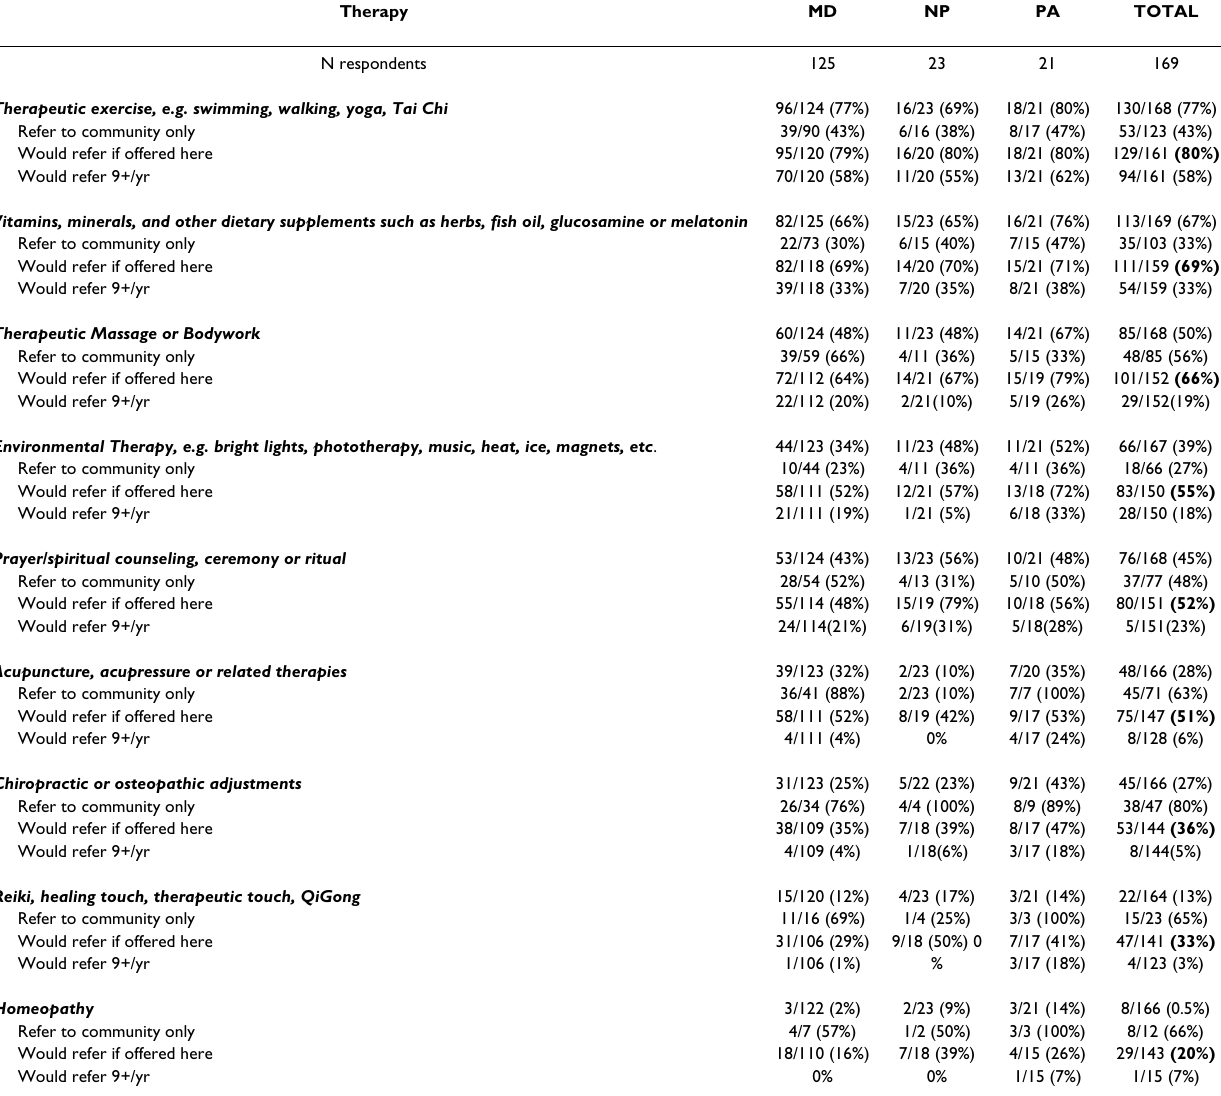
Table 2: Therapeutic recommendations or referrals for specific ancillary services Therapy MD NP PA TOTAL N